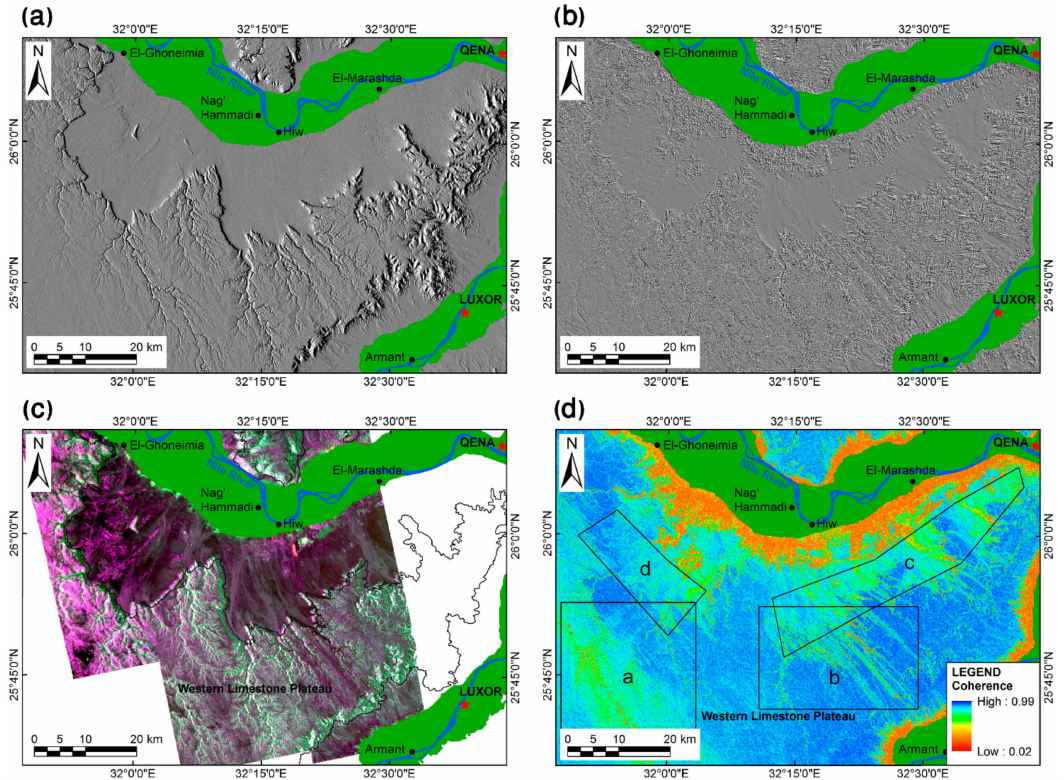
Figure 4. ( a ) Hillshaded DEM with an illumination angle of 270 ◦ ; ( b ) Sobel-filtered Landsat-8 panchromatic band highlighting the NW–SE direction; ( c ) Pauli RGB image of the full-polarimetric ALOS / PALSAR-1 image; ( d ) Sentinel-1 InSAR coherence